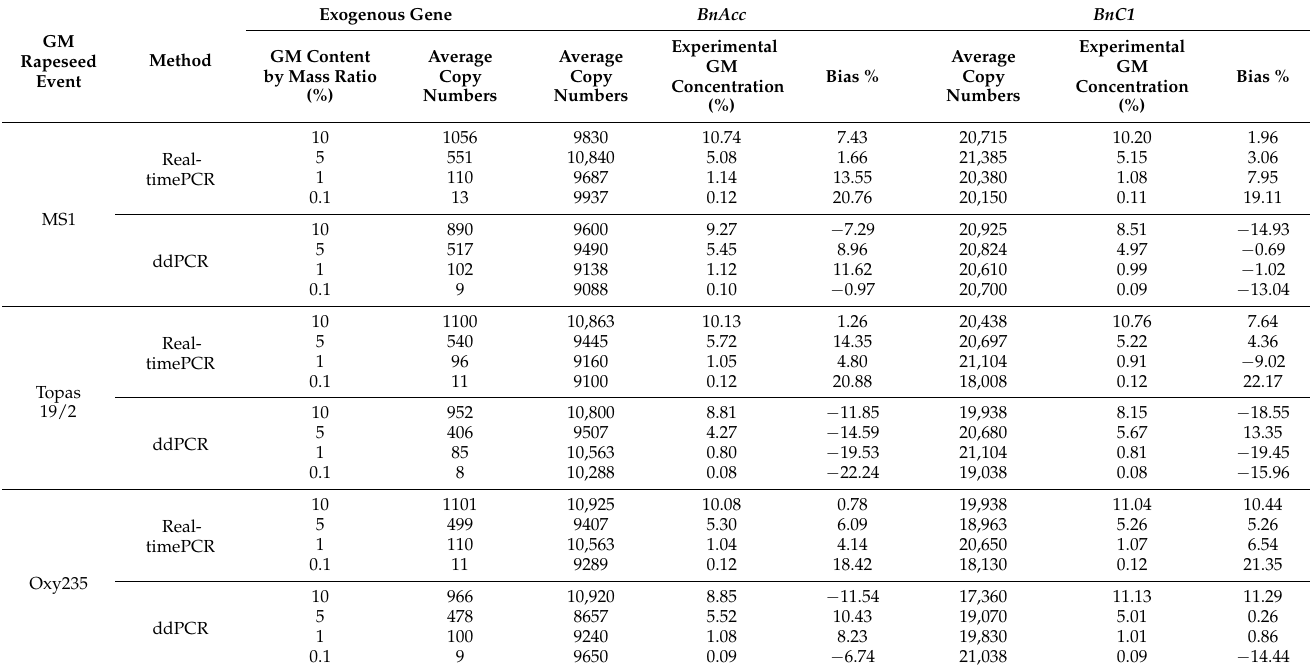
Figure 4. Validation of the RT-PCR and ddPCR methods using blinded samples with ERGs of BnAcc and BnC1 assays. The standard curves for the MS1-specific RT-PCR method using gradient-diluted MS1 genomic DNA as the template were analyzed using CFX96 System. gDNA samples with mass fractions of 10%, 5%, 1%, and 0.1% of MS1 were used as a template to quantify the specific MS1 gene ( A ) and reference BnC1 ( B ) and BnAcc ( C ) on the RT-PCR platform. The same samples were amplified on a ddPCR of MS1-specific gene ( D ); amplification of BnC1 and BnAcc genes ( E ). Table 5. Droplet digital PCR results obtained for GE canola samples using six reference